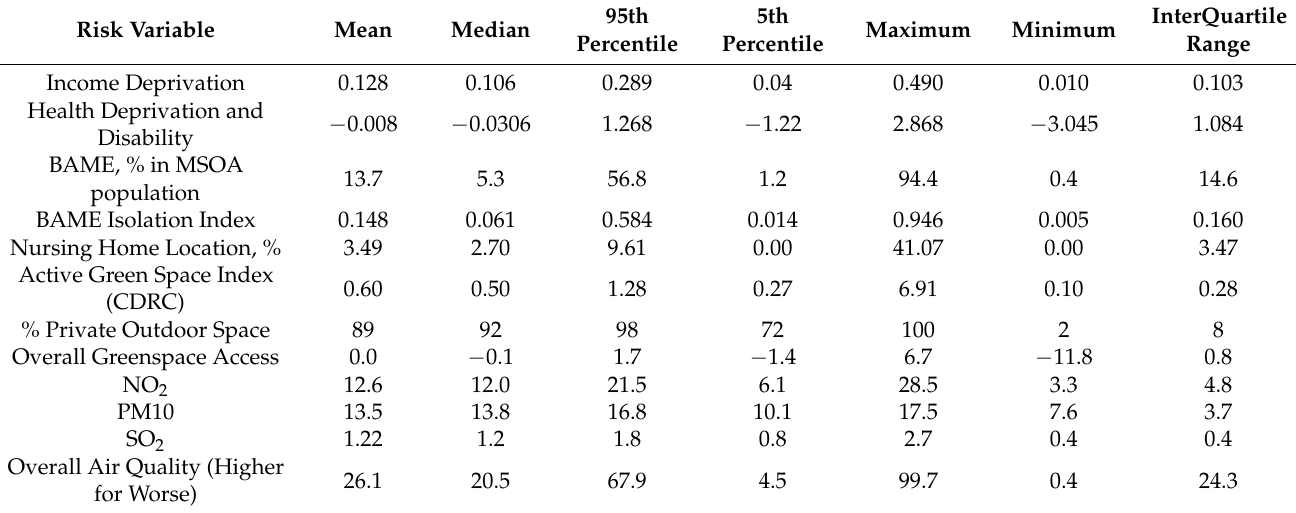
Table 1. Distributional Characteristics of Area Risk Variables.